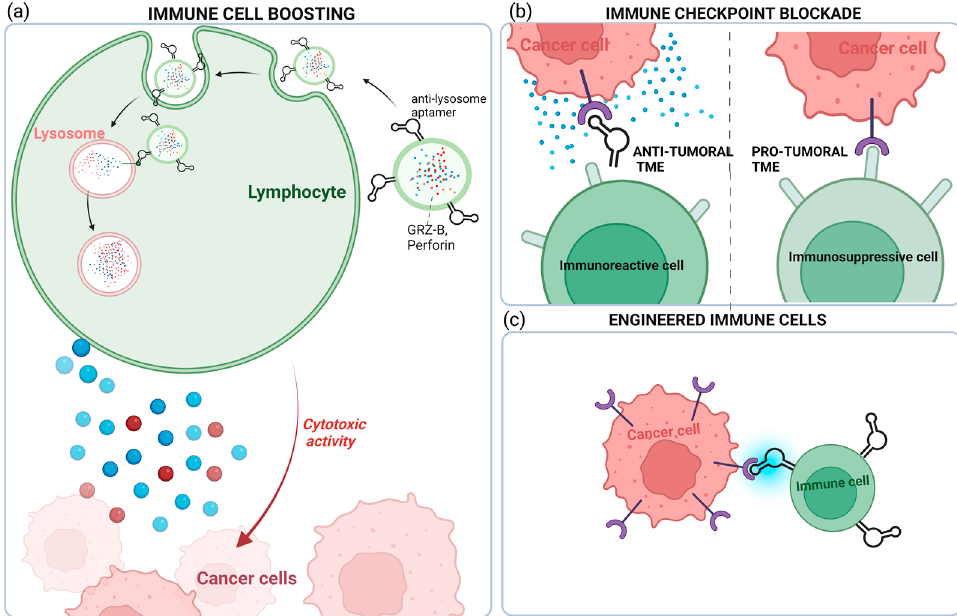
Figure 4. Aptamer-based strategies to restore an antitumoral immune TME. In TNBC, aptamers have been used for: ( a ) potentiating the cytotoxic activity of CD8+ T cells; ( b ) blocking immune checkpoint proteins from binding with their partners; and ( c ) restoring antitumoral TME through the recruitment of aptamer-engineered immune cells (macrophages and NK cells) to the tumor (see text for details). Created with BioRender.com (accessed on 2 March 2023).